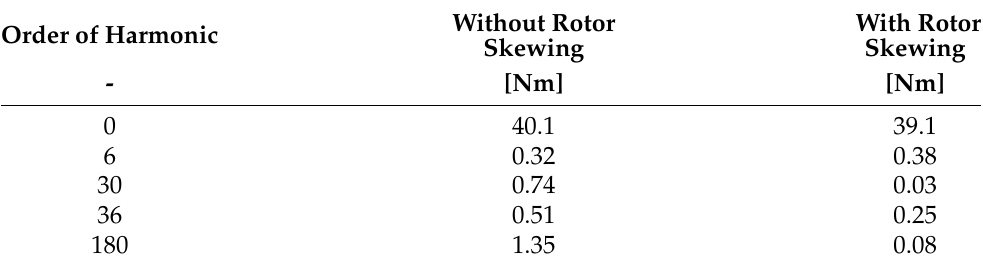
Table 3. Torque harmonics comparison.